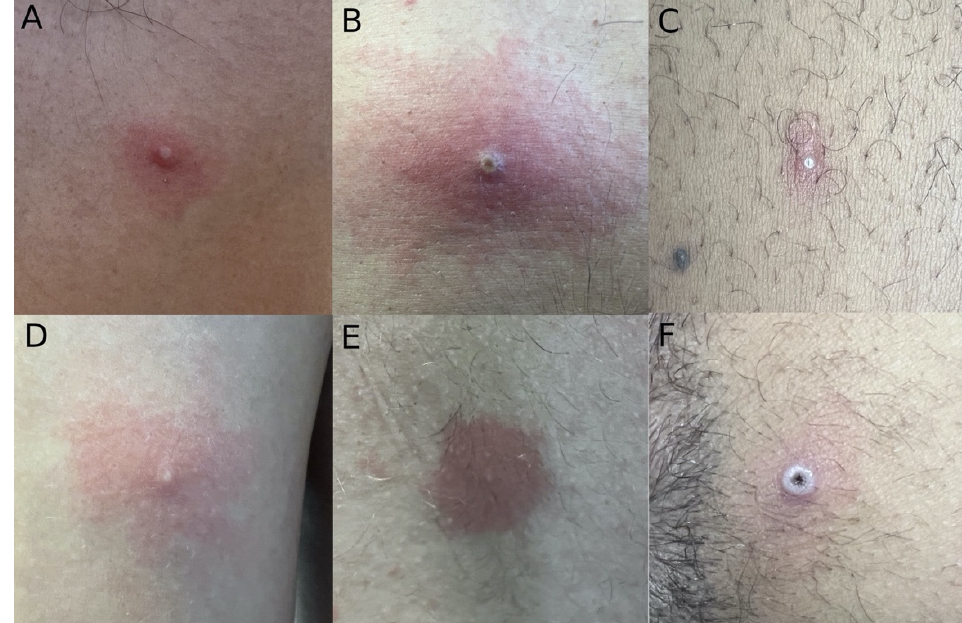
Figure 3. MPX typical skin lesions. ( A ) White papule with an erythematous halo. ( B ) Whitish papule with a necrotic center in an erythematous background. ( C ) Millimetric white papule with an erythematous halo. ( D ) White papule with erythematosus background. ( E ) Millimetric whitish papule with a well-defined erythematous halo. ( F ) White umbilicated papule with a necrotic center.